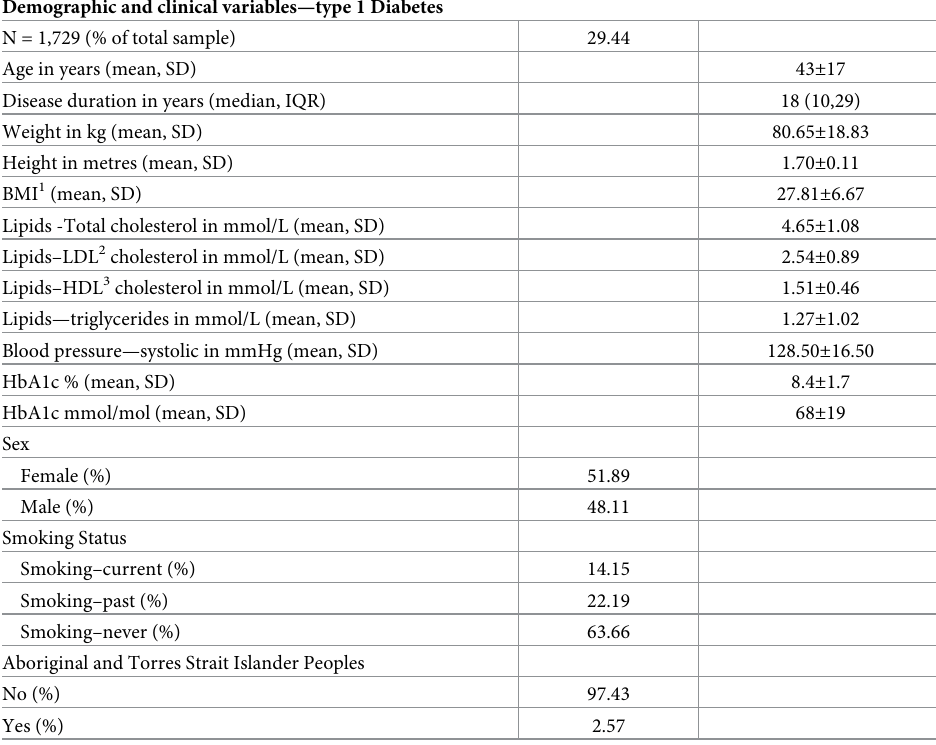
Table 1. Patient demographic and clinical variables–type 1 Diabetes. Characteristics of the sample with type 1 diabetes are shown. 1 BMI: Body Mass Index (calculated in kg/m 2 and categorised according to guidelines from the World Health Organization [25]). 2 LDL: Low-density